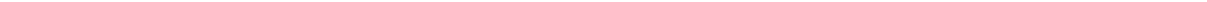
Fig. 3 ATR is required for homologous synapsis. Examples of early pachytene synaptic outcomes in a Atr fl / + males ( n = 3 males) and b Atr fl / – males ( n = 3 males) assessed using HORMAD2 (magenta), SYCP3 (green) and subsequent DNA FISH using Slx and Sly probes (labeled in insets as X chromosome in green and Y chromosome in white). The Slx probe hybridizes to a sub-region of the X chromosome (circled), while the Sly probe coats the majority of the Y chromosome. In Atr fl / + males ( a ), both the autosomes and the XY PARs are synapsed, while the non-homologous regions of the XY pair are asynapsed. In Atr fl / + males ( n = 104 cells, 2 males), 90 cells had normal synapsis, 12 cells had asynapsis of both the XY and autosomes, 1 cell had asynapsis only of the XY and 1 cell had asynapsis only of the autosomes. b Three examples of synaptic defects in Atr fl / – males, each described above respective image. In Atr fl / – males ( n = 107 cells, 2 males), 21 cells had normal synapsis, 59 cells had asynapsis of both the XY and autosomes, 23 cells had asynapsis only of the XY, 4 cells had asynapsis only of the autosomes, 10 cells had X self-synapsis, 11 cells had Y self-synapsis and 7 had non-homologous synapsis between the X and/or Y and autosomes. c , d Comparison of pachytene synaptic outcomes in c Spo11 − / − and d Atr fl / – Spo11 − / − males using immunostaining for SYCE2 (magenta) and SYCP3 (green). e Quantitation of complete, partial and focal SC in Spo11 − / − males ( n = 2 males; 88 cells) and Atr fl / – Spo11 − / − males ( n = 2 males; 96 cells). Means and p values (unpaired t -test) indicated. f – h Epistasis analysis of SPO11 and ATR in synapsis using the same markers plus immunostaining for centromeres (CENT; white) to determine CS number. For each cell, colocalizing SYCE2-CENT signals are indicated with dashed circles, and resulting CS numbers are shown. i CS number in Atr fl / + males ( n = 2 males; 55 cells), Atr fl / – males ( n = 2 males; 37 cells), Spo11 − / − males ( n = 2 males; 114 cells) and Atr fl / – Spo11 − / − males ( n = 2 males; 64 cells). Mean values and p values (Mann – Whitney test) indicated. Scale bars 10 µ